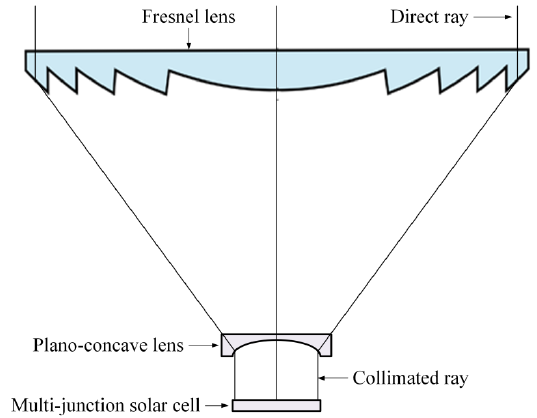
Figure 3. Design of the proposed CPV unit with the secondary optical element (SOE).